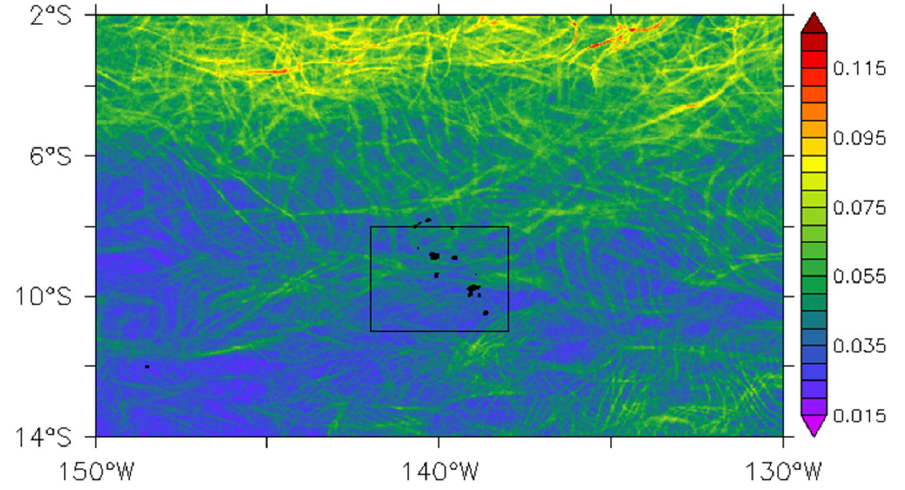
Figure 3. Root mean square (RMS) of FLSEs in 1998. The black box delineates the area over which